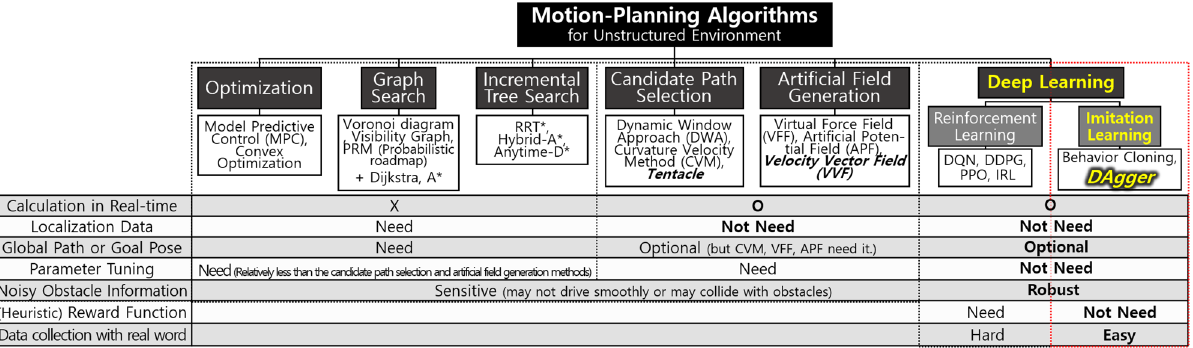
Figure 1. Motion-planning algorithms and comparison between the